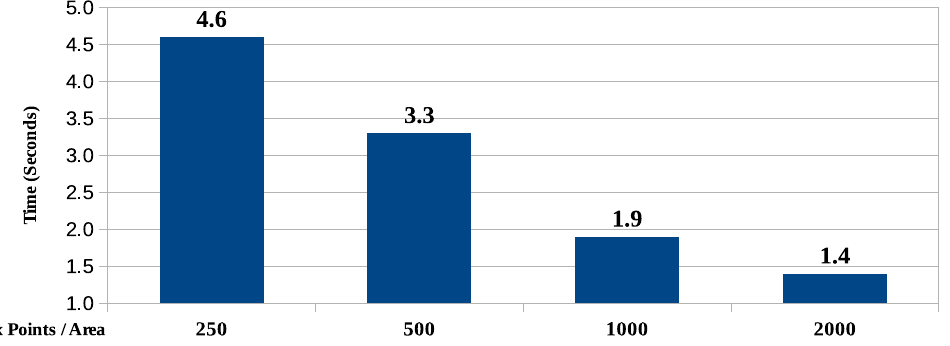
Figure 15. Response time by maximum points by area. Source: the